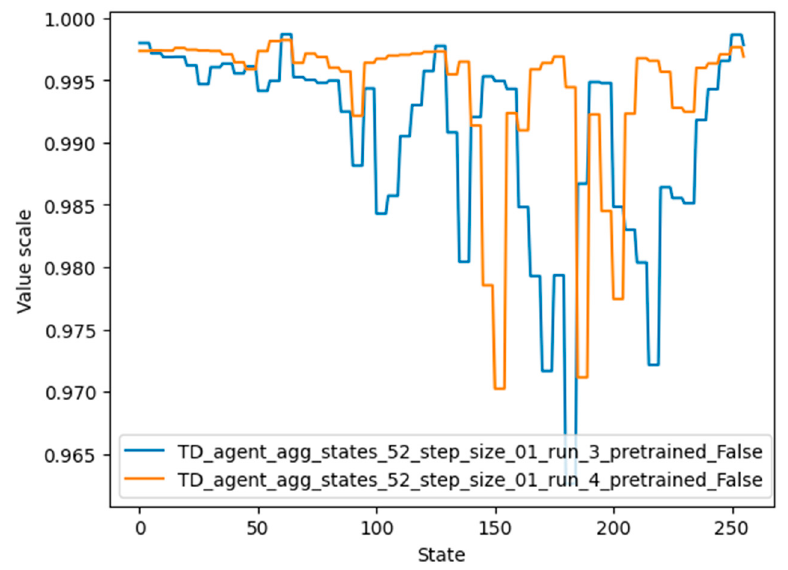
Figure 14. Values for states of the environment, learned by agent numbers 3 and 4 (the best-performing agent).